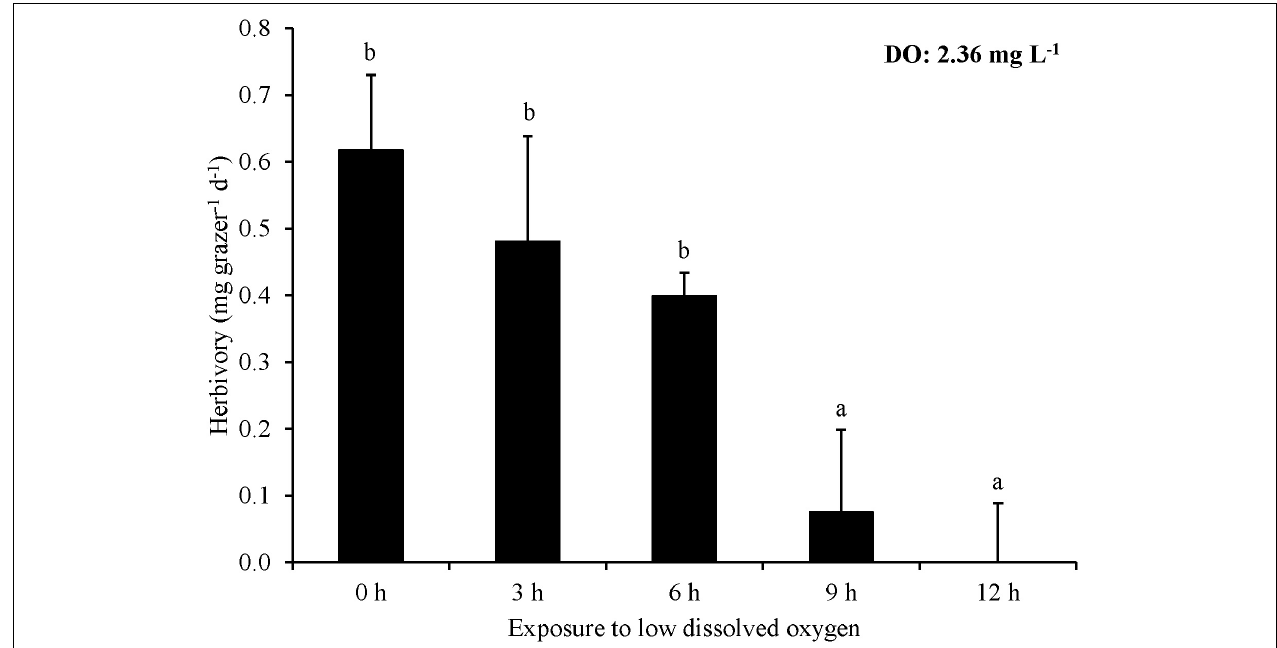
FIGURE 6 | Herbivory rates of L. vincta initially starved for 24 h under ambient pH/DO and allowed to graze on U . rigida for 12 h with varying durations of exposure (0 – 12 h) to low DO concentrations (2.36 mg L − 1 ) (Experiment 6; Table 2 ). Statistical analyses: One-way ANOVA and post hoc Tukey Honest Significant Difference tests performed; significant differences between treatments represent p -values less than